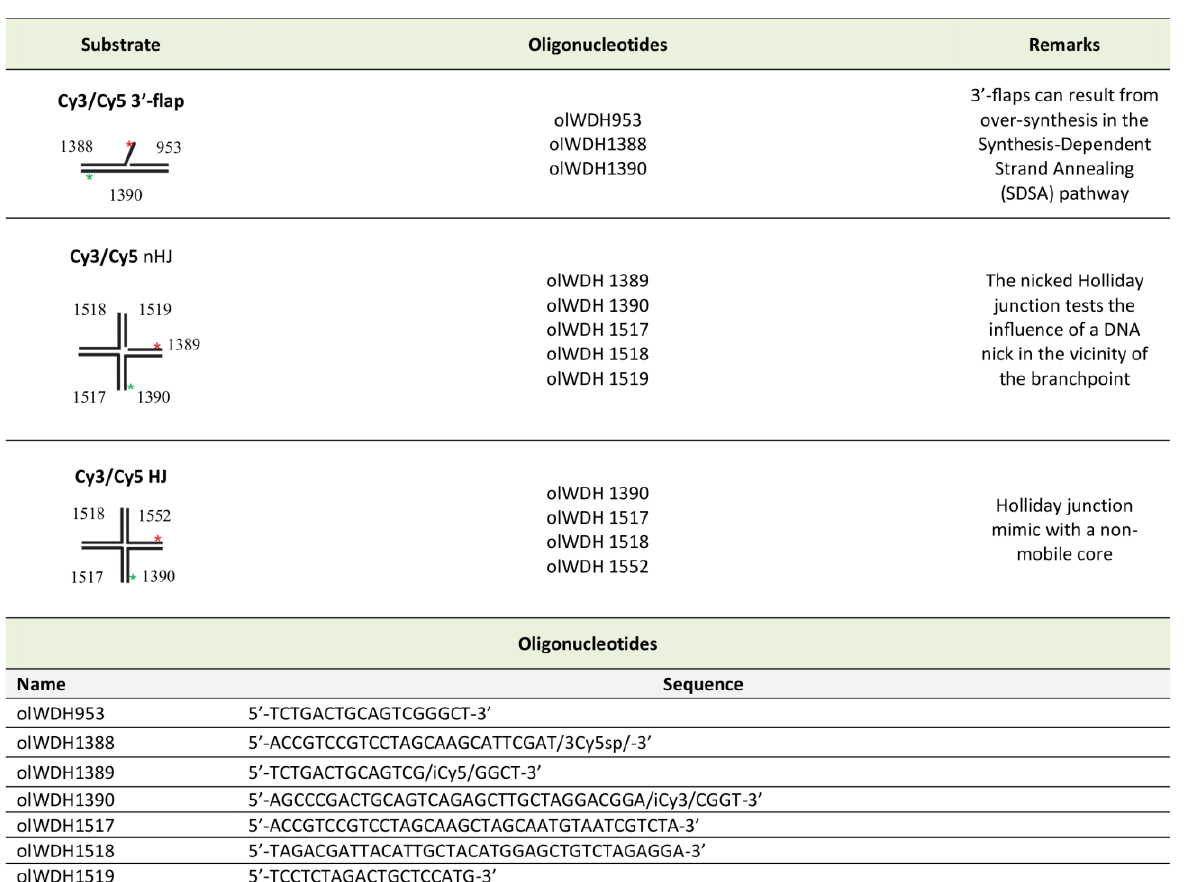
Table 1. Substrates and their oligonucleotide names and sequences. Cy3 and Cy5 fluorophores are usual ly at the 3’